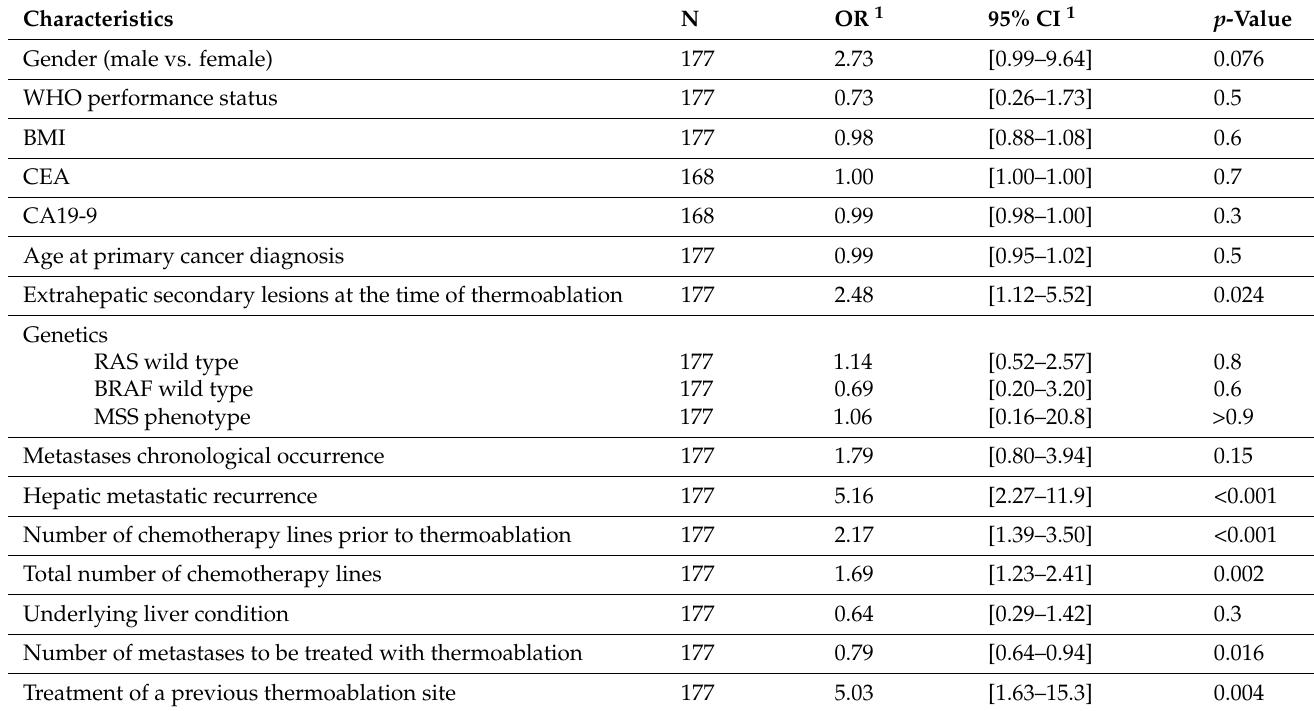
Table 4. Relation between patient characteristics and local recurrence.